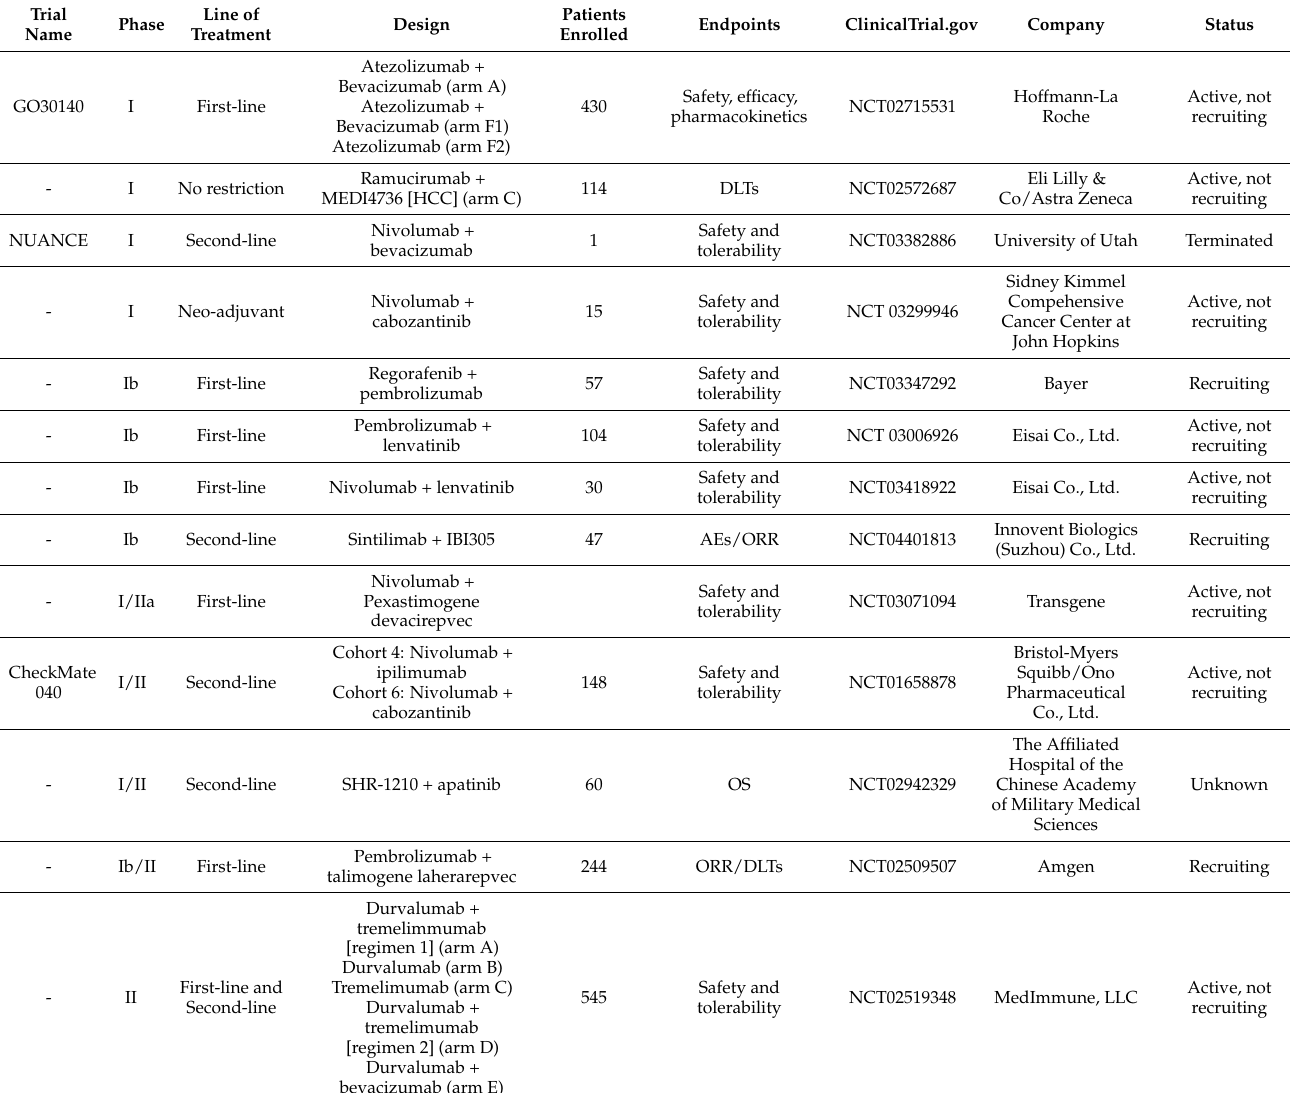
Table 1. Ongoing clinical trials with immune checkpoint inhibitors, alone or in combination with other agents, in